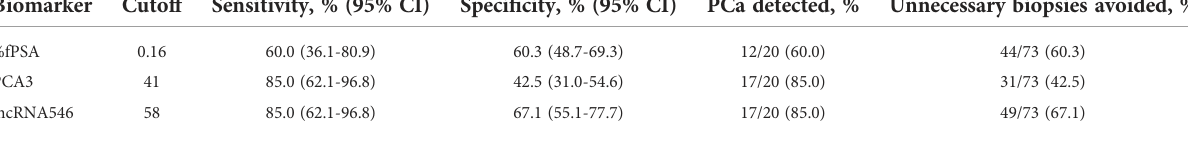
TABLE 2 Comparison of %fPSA, PCA3 and lncRNA546 with respect to speci fi c diagnostic performance at the recommended cutoff values in the PSA gray area cohort.